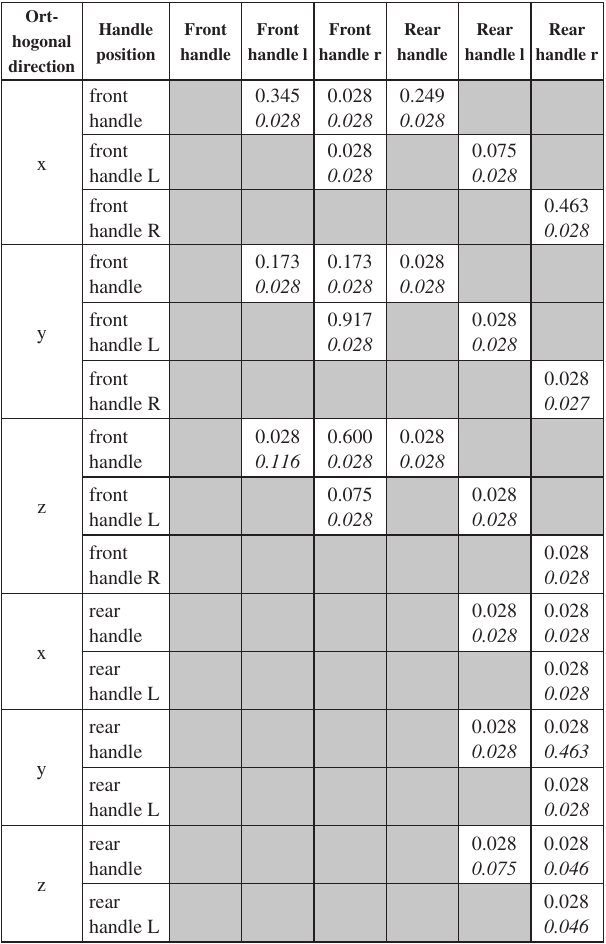
Table 3 Statistical significance ( p -values) of differences in mean r.m.s. accelerations obtained with different operation (i.e. idling and cutting) and holding positions (Wilcoxon matched-pairs signed ranks